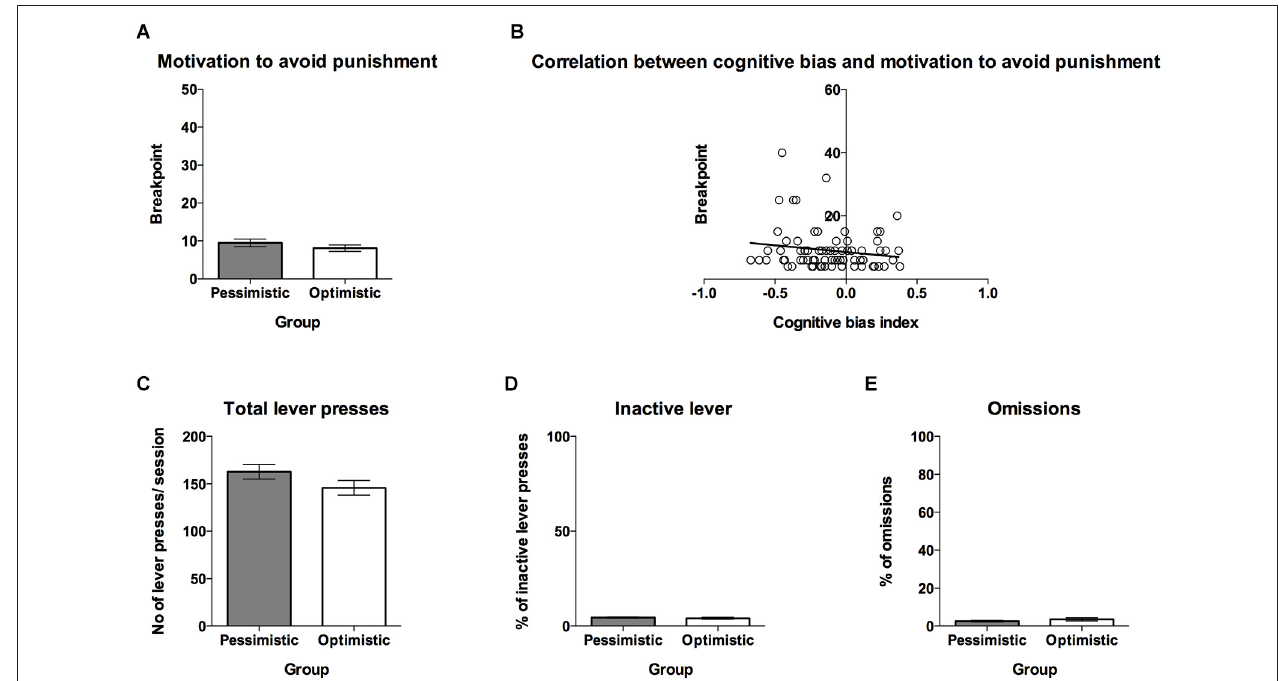
PR schedule of reinforcement test session by animals classified as “optimistic” vs. “pessimistic”. (D) The mean ± SEM percentage of inactive lever presses made during one PR schedule of reinforcement test session by animals classified as “optimistic” vs. “pessimistic”. (E) The mean ± SEM percentage of omitted responses during one PR schedule of reinforcement test session by animals classified as “optimistic” vs. “pessimistic”. * indicates significant ( p < 0.05) differences between the “optimistic” and “pessimistic”